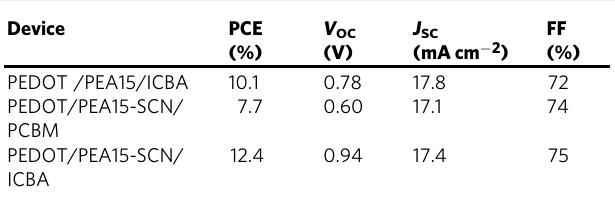
Table 1 Summary of the best performance devices with